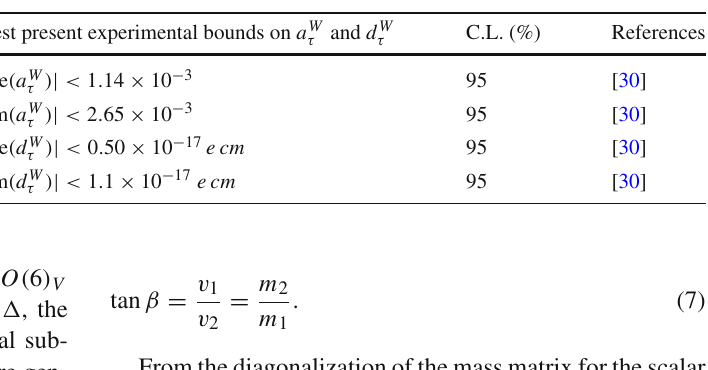
Table 2 The best current experimental results for the weak dipole moments of the τ -lepton